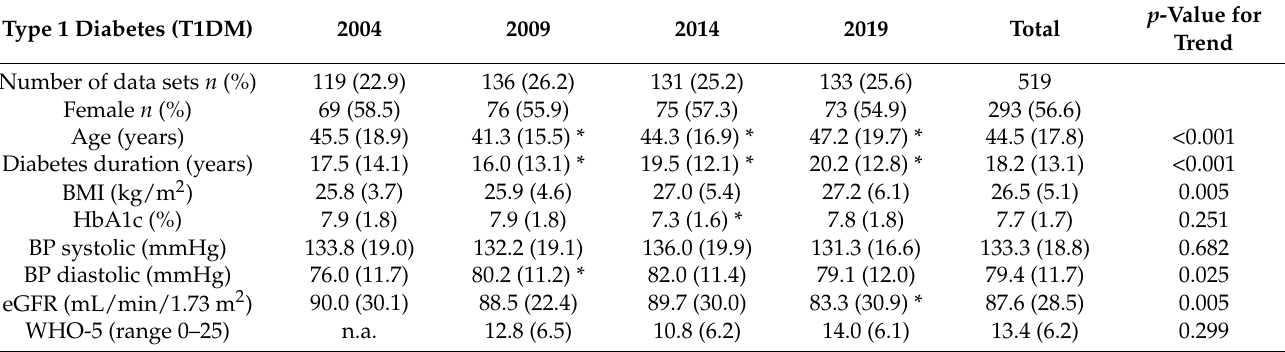
Table 2. Characteristics and metabolic control of patients in tertiary care